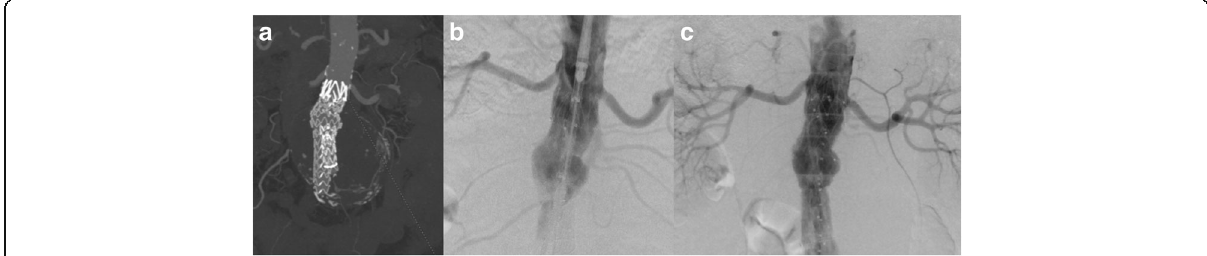
Fig. 1 a Coronary reconstruction of CTA scan confirming deployment of the graft in a caudal position led to sac expansion in the follow-up period. b Angiogram confirmed the low graft position. c A cuff was deployed in an immediate infrarenal position to prevent any further